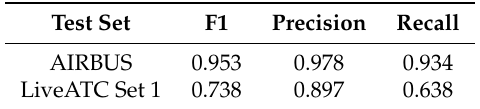
Table 4. Current performance of the named entity recognition